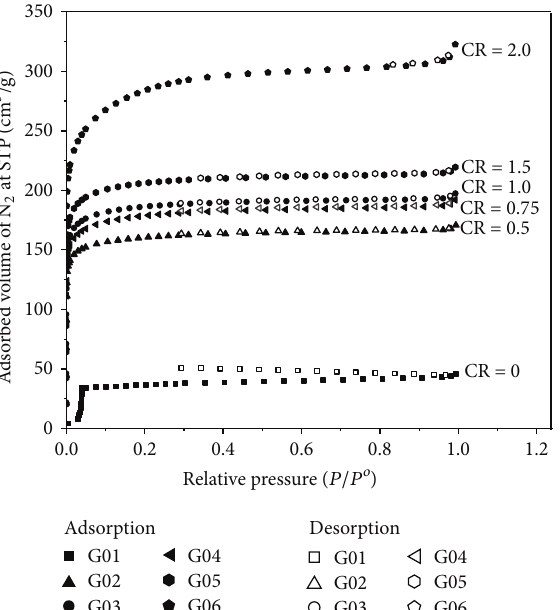
Figure 9: Effect of chemical ratio on nitrogen isotherm at 77K of activated carbon samples produced by CO 2 gasification of coconut shell at 600 ∘ C for